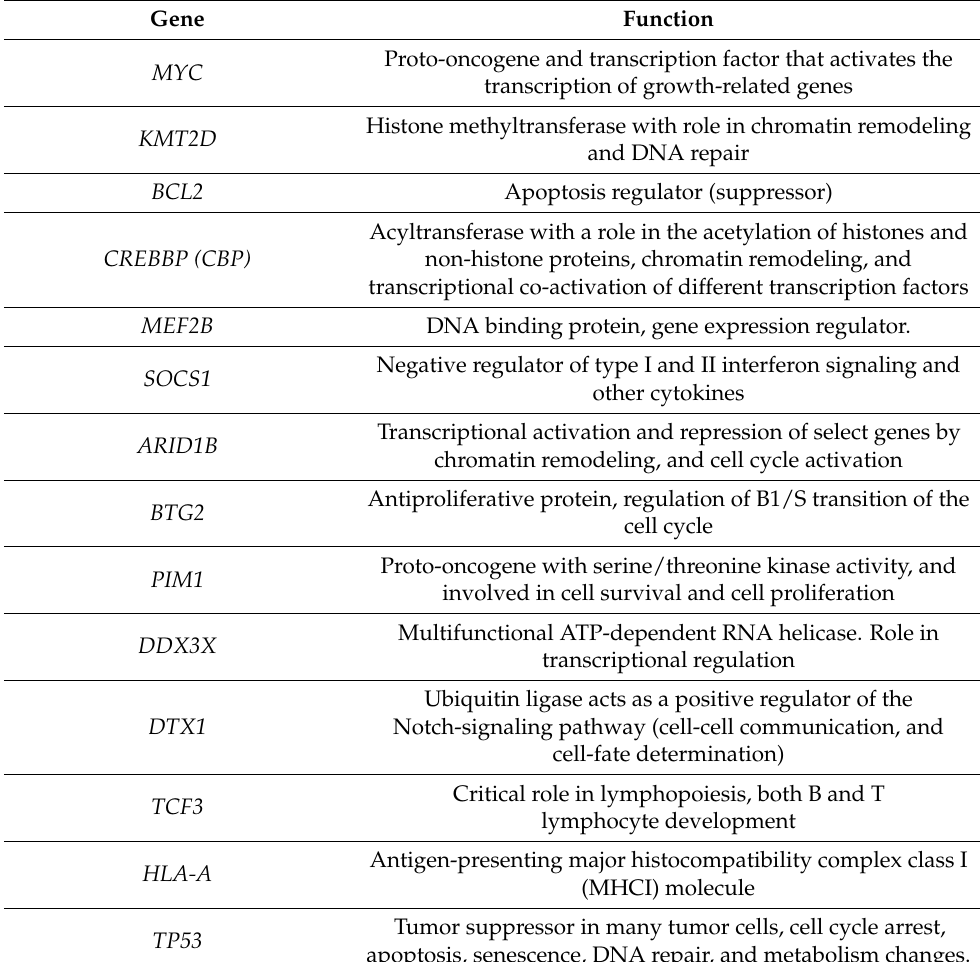
Table 1. Function and role of the most relevant mutated genes. Gene Function Proto-oncogene and transcription factor that activates the MYC transcription of growth-related genes Histone methyltransferase with role in chromatin remodeling KMT2D and DNA repair BCL2 Apoptosis regulator (suppressor) Acyltransferase with a role in the acetylation of histones and CREBBP (CBP) non-histone proteins, chromatin remodeling, and transcriptional co-activation of different transcription factors MEF2B DNA binding protein, gene expression regulator. Negative regulator of type I and II interferon signaling and SOCS1 other cytokines Transcriptional activation and repression of select genes by ARID1B chromatin remodeling, and cell cycle activation Antiproliferative protein, regulation of B1/S transition of the BTG2 cell cycle Proto-oncogene with serine/threonine kinase activity, and PIM1 involved in cell survival and cell proliferation Multifunctional ATP-dependent RNA helicase. Role in DDX3X transcriptional regulation Ubiquitin ligase acts as a positive regulator of the DTX1 Notch-signaling pathway (cell-cell communication, and cell-fate determination) Critical role in lymphopoiesis, both B and T TCF3 lymphocyte development Antigen-presenting major histocompatibility complex class I HLA-A (MHCI) molecule